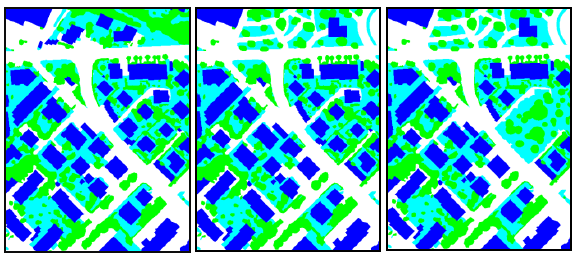
Figure 4. Area 30 in Vaihingen. Left: reference; centre: simulated topographic database (variant 30_1), right: simulated topographic database (variant 30_2). Colours: white: impervious surface ; blue: building ; green: tree ; cyan: low vegetation .